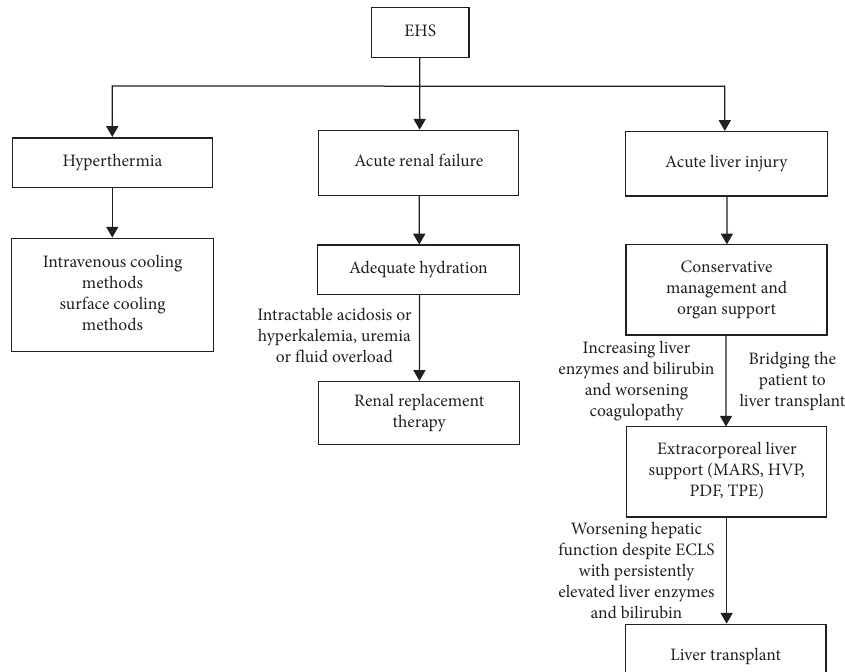
Figure 4: Algorithm for management of organ failure in exertional heat stroke (EHS). Molecular Adsorbent Recirculating System (MARS), high-volume plasma exchange (HVP), plasmadiafiltration (PDF), and total plasma exchange (TPE) are examples of extracorporeal liver support